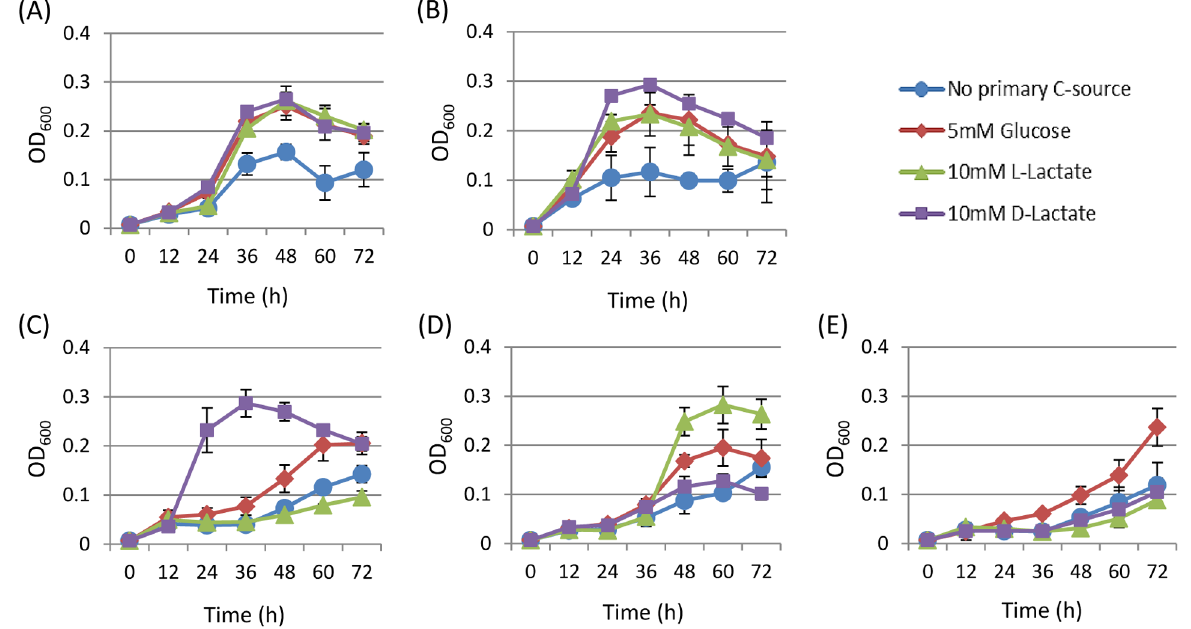
Figure 2. Growths of H.pylori26695 wild type (A), the D 140 mutant (B), the D 138 mutant (C), the D 1222 mutant (D), and the D 138/ D 1222 mutant (E) cultured in PP medium with/without a particular carbon source; no primary carbon source (blue circle), 5 mM D- glucose (red diamond), 10 mM L-lactate (green triangle), 10 mM D-lactate (purple square). The cell growth was monitored by measuring the optical density at 600 nm. The data points and error bars represent the means 6 SD of three independent experiments.